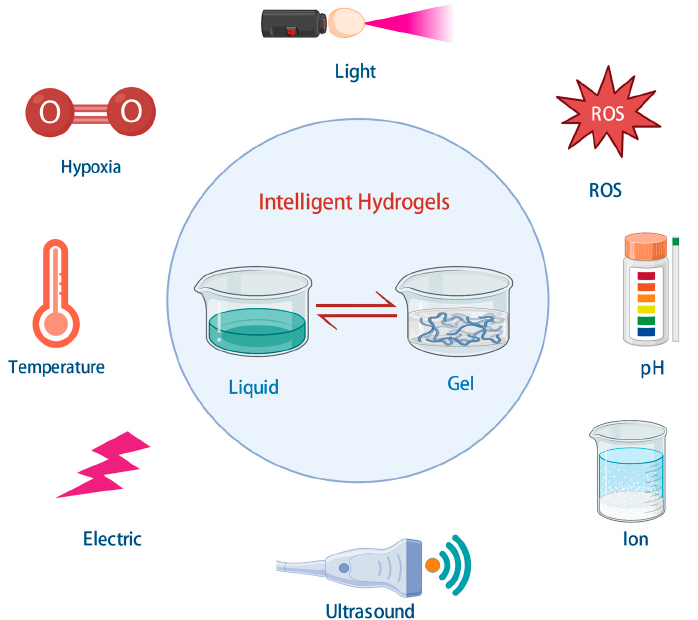
Figure 2. Intelligent hydrogels and cardiac tissue engineering. Created with BioRender.com.